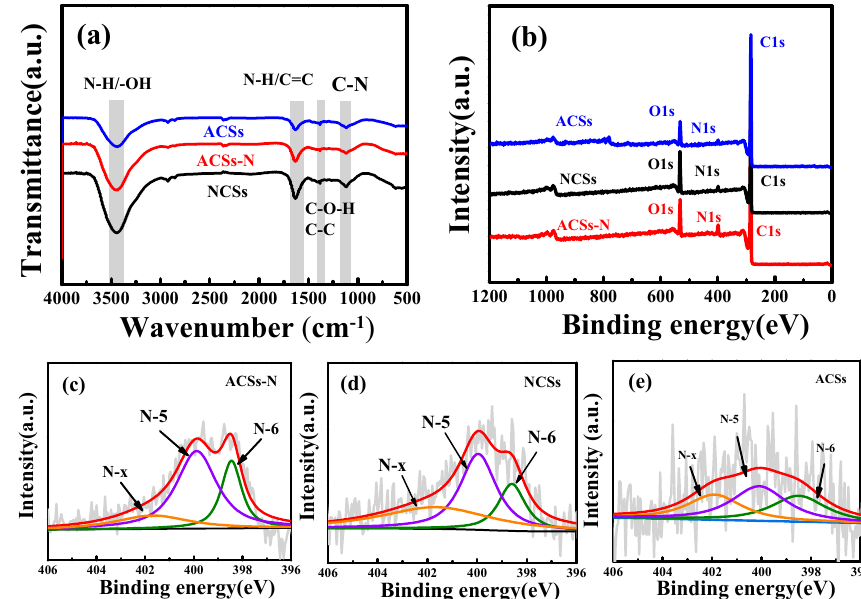
Figure 5. ( a ) FT-IR spectra and ( b ) X-ray photoelectron spectroscopy (XPS) survey spectra of the porous carbons ACSs, NCSs, and ACSs-N. The N1s high-resolution spectra of ( c ) ACSs-N, ( d ) NCSs, and ( e ) ACSs.